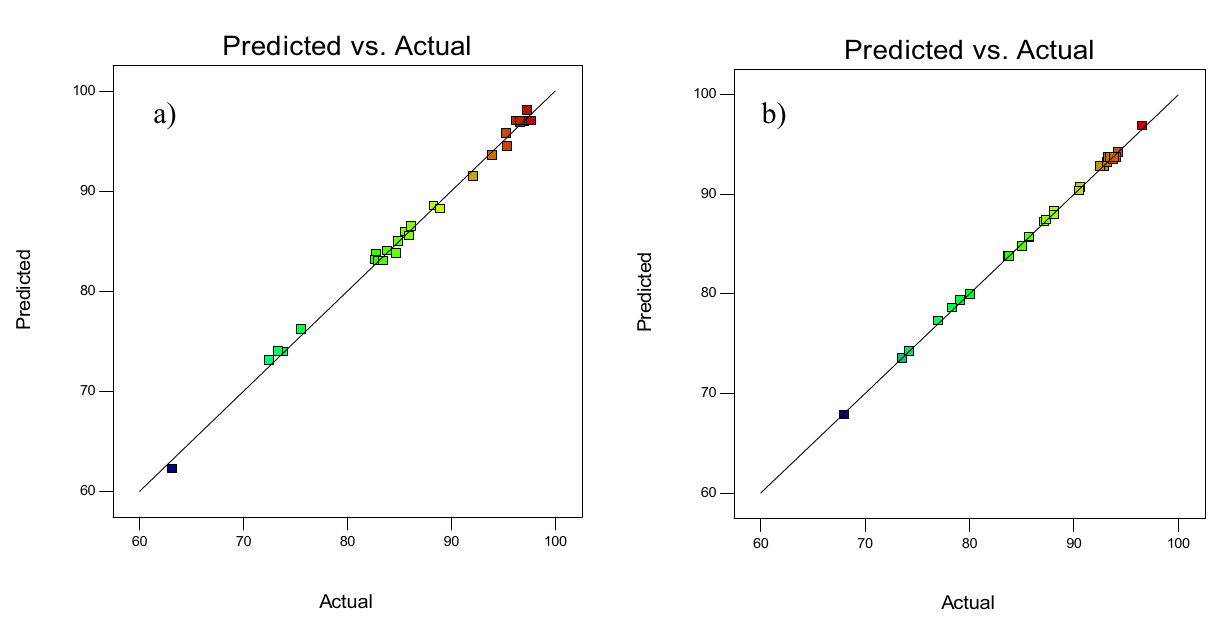
Figure 3. Predicted versus experimental data for extraction of ( a ) AO and ( b ) MB (Image is created by using Design-Expert software version